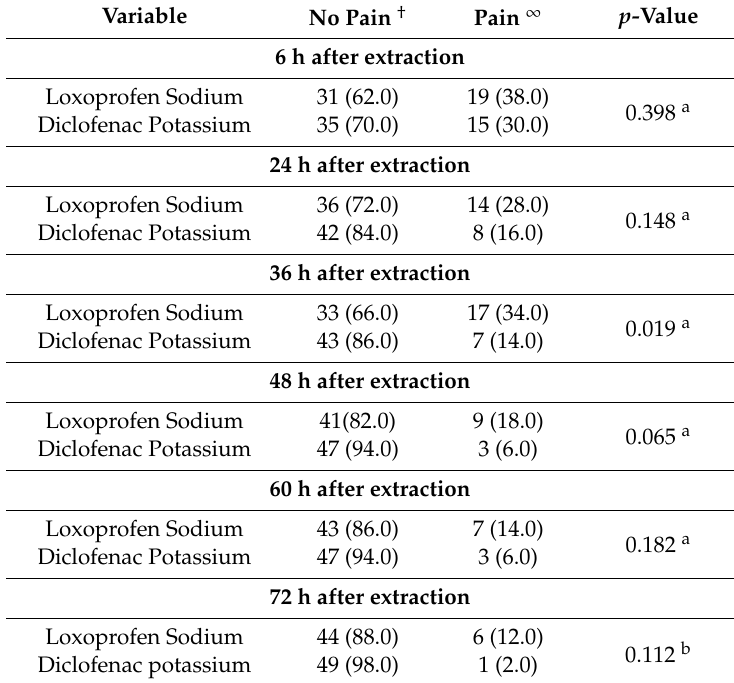
Table 2. Comparisons of loxoprofen sodium and diclofenac potassium post-operative pain perception ( n =